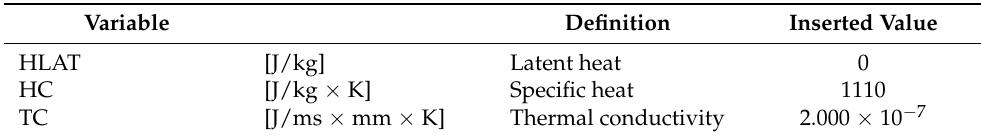
Table 7. T01 material parameters for the thermal isotropic characteristic of F3900, as published in